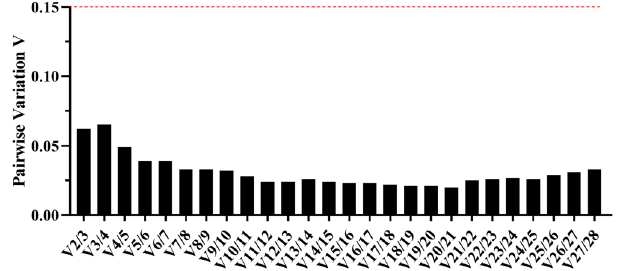
Figure 3. Pairwise variation measured using geNorm to determine the optimal number of reference genes for normalization. The dash line indicates the cut-off value of 0.15. It was performed using GraphPad Prism version 8.0.1 for Windows (GraphPad Software, San Diego, California USA, www.graph